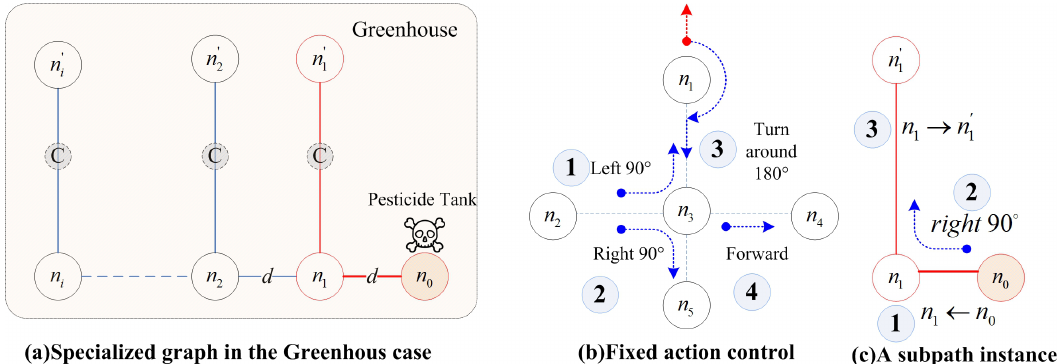
Figure 6. Specialized undirected weighted connected graph and fixed action